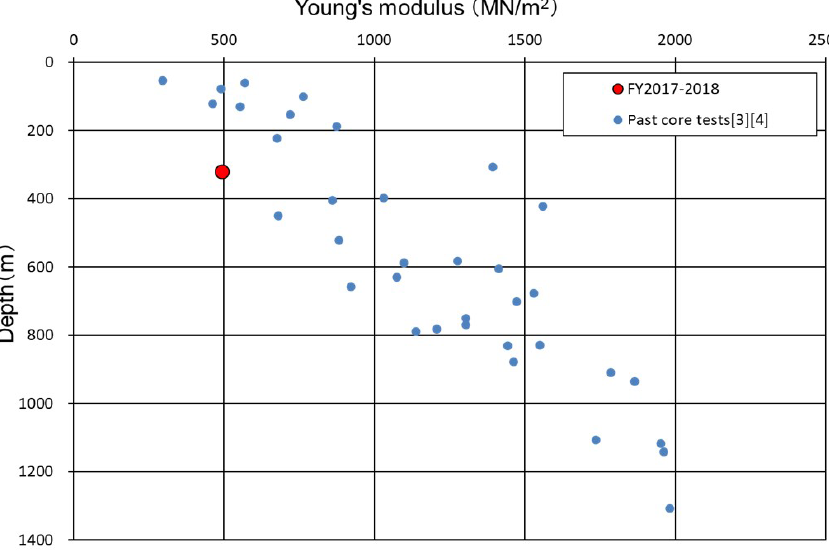
Figure 3. Correlation of Young’s modulus and depth (Nakagawa and Sekine,